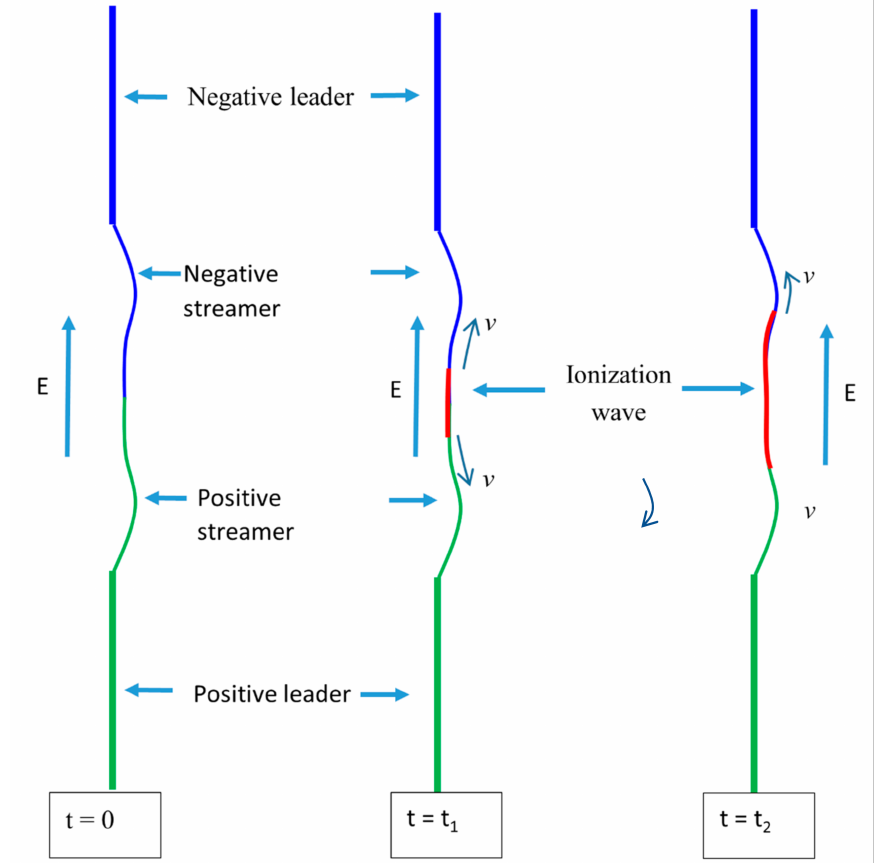
Figure 2. Pictorial depiction of the propagation of a highly conducting ionization wave at the meeting point of oppositely polarized streamers. The waves start at the meeting point and travel in both directions along the streamer channel with speed v. As time increases the length of the highly conducting region caused by the ionization wave